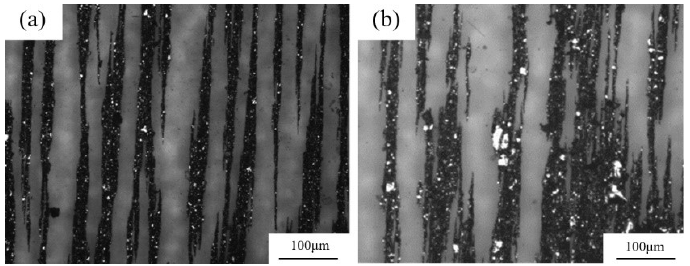
Figure 12. Ferrography of abrasive grains for 10 mm gear at severe wear stages ( a ) abrasive particle diagram of 10 mm tooth width during stable wear period, ( b ) abrasive grain diagram of 10 mm tooth width near failure.